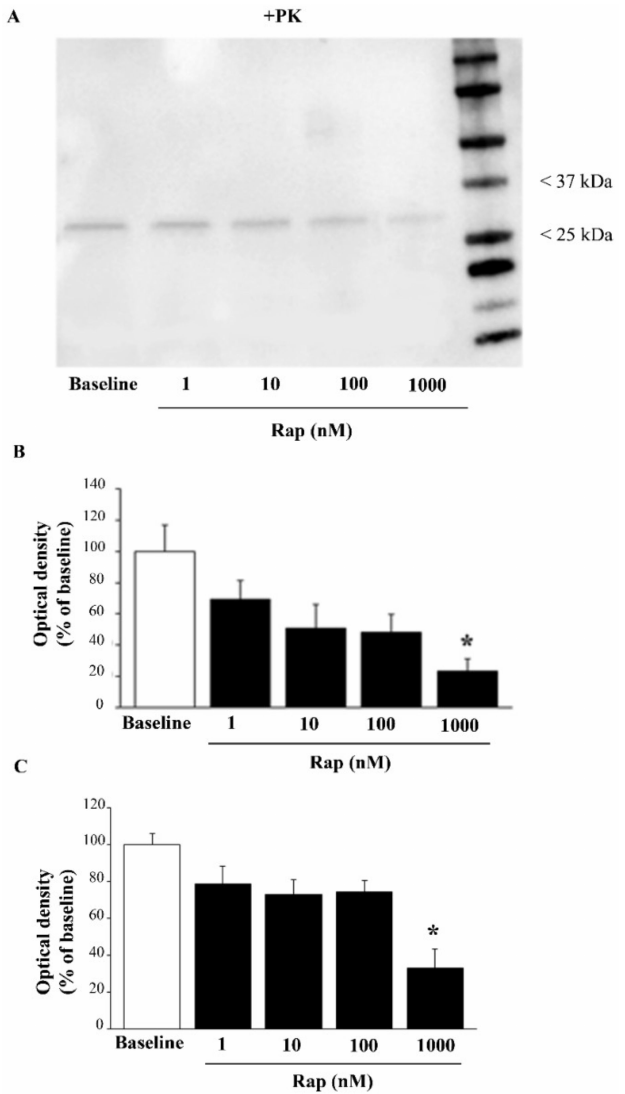
Figure 9. Rapamycin reduced the amount of PK-resistant α -syn. ( A ) Representative PK-resistant immunoblotting of α -syn in baseline conditions (baseline) and in rapamycin-treated U87MG cells (data were validated in N = 3 different gels). Graphs report densitometry as a percentage of baseline (assuming the baseline to be 100%) ( B ) or as a ratio between PK-resistant α -syn and β -actin (as in the gel without PK treatment), assuming the baseline to be 100% ( C ). Data are given as the mean percentage ± SEM of optical density of n = 3 blots for each experimental group, measured in N = 3 independent experiments. The original figure of Figure 8A can be found in Supplementary Figure S5. * p < 0.05 compared with